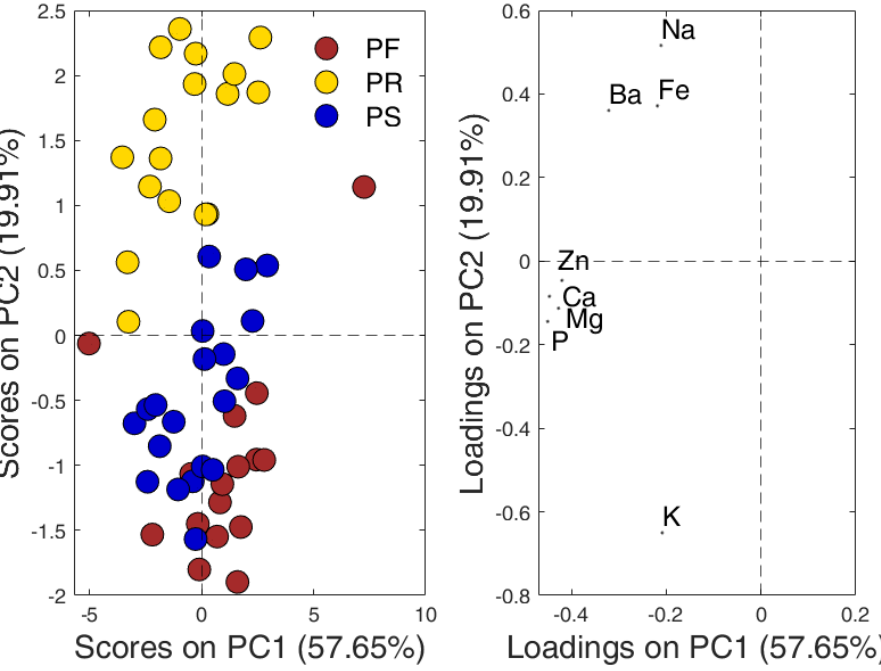
Figure 2. Projection of Pecorino samples ( left ) and variable loadings ( right ) on the first two principal components (PC1 and PC2).